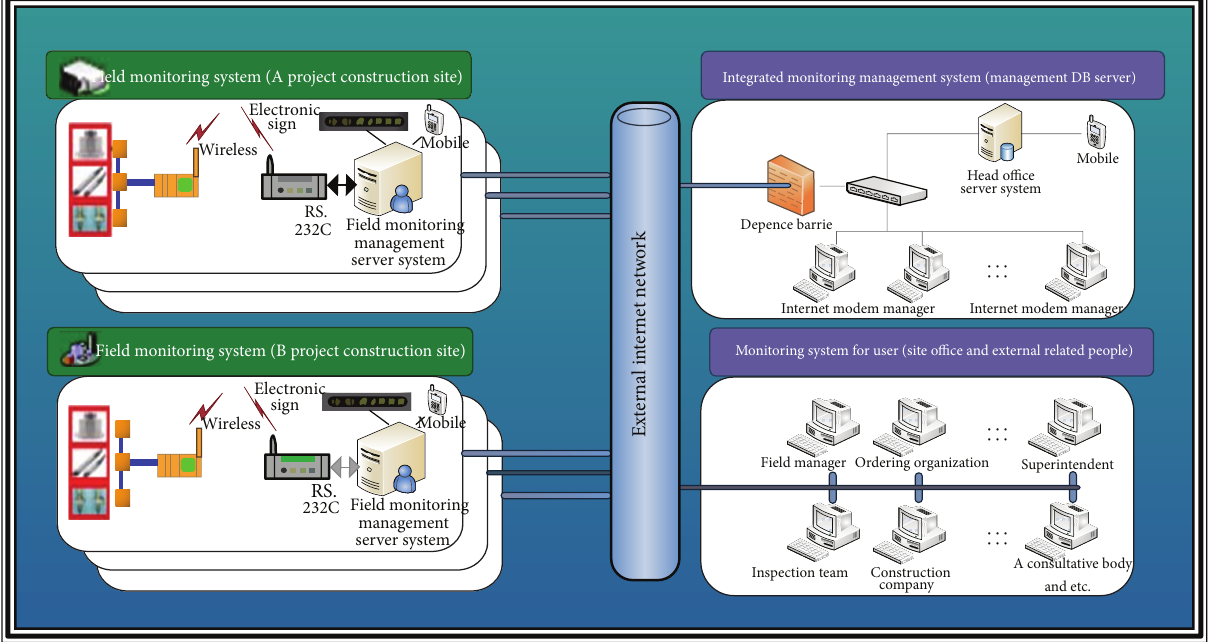
Figure 2: The overall diagram of monitoring